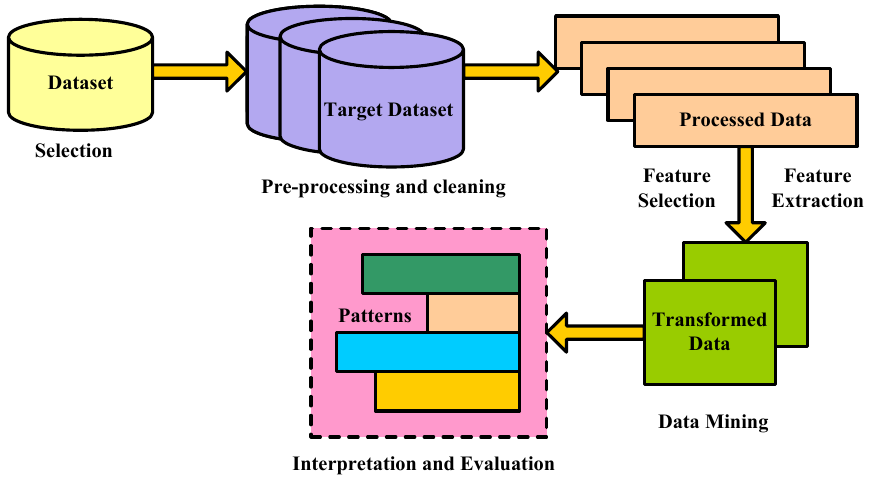
Figure 2. Feature Selection and Feature Extraction from Dataset.